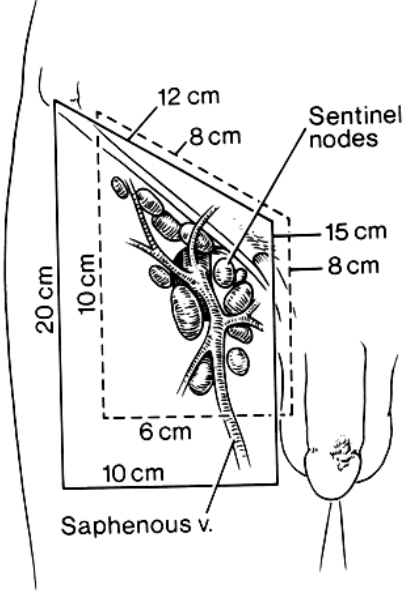
FIGURE 4 . Limits of the classic and modified inguinal